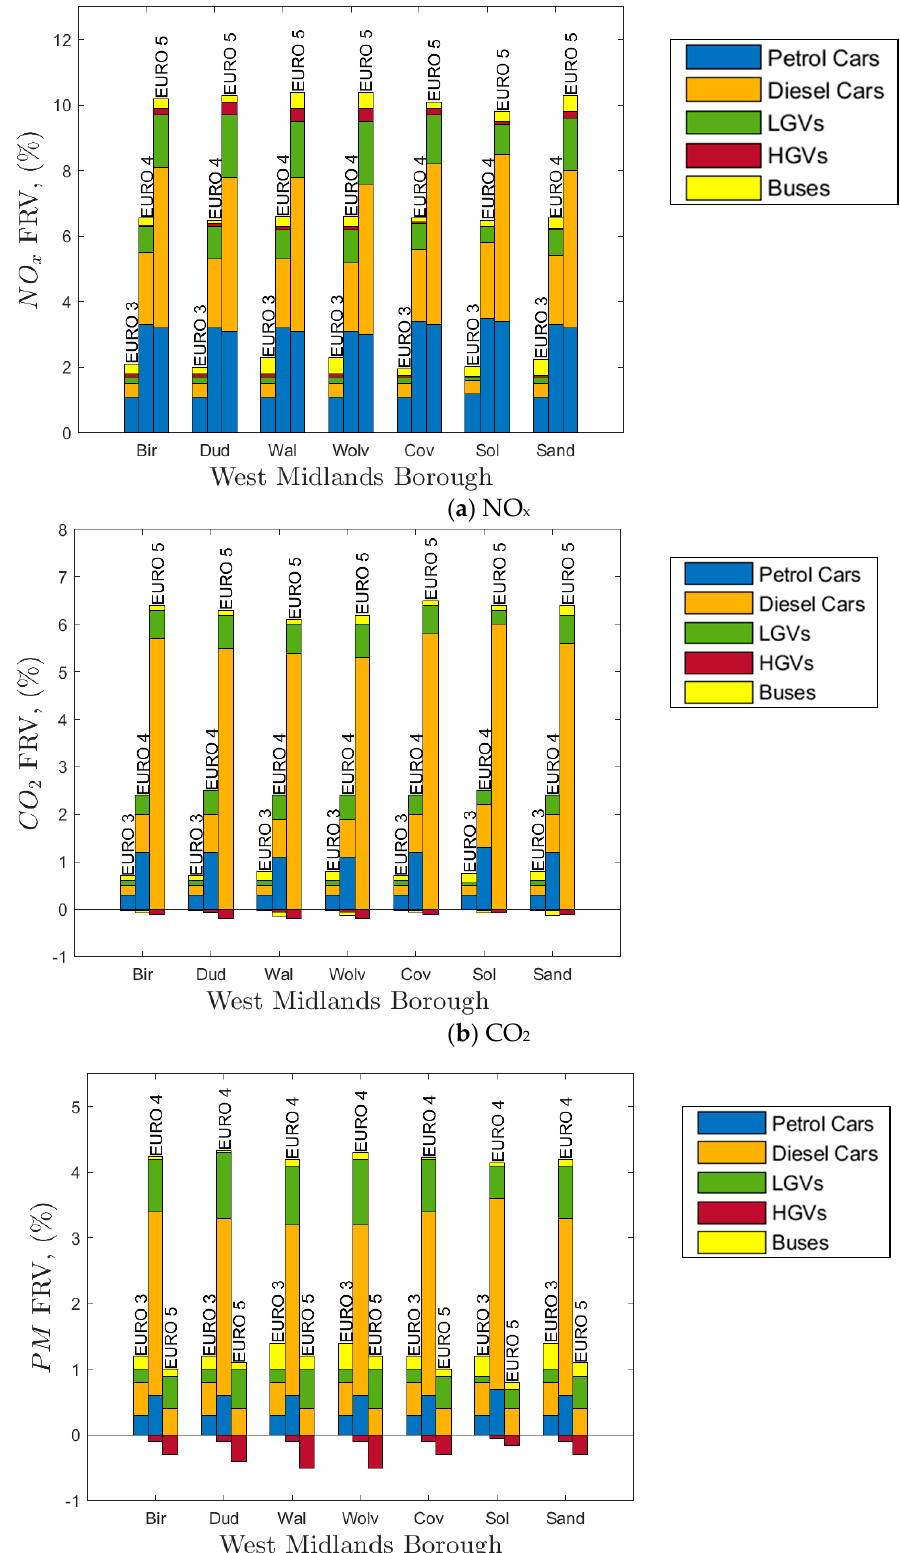
Figure 5. The effect of fleet replacement on the percentage reduction of total fleet emissions of ( a ) NO x , ( b ) CO 2 , and ( c ) PM subset by EURO class and vehicle type on urban roads, for each West Midland borough. On the y-axis, (%) is based on the total fleet emission.